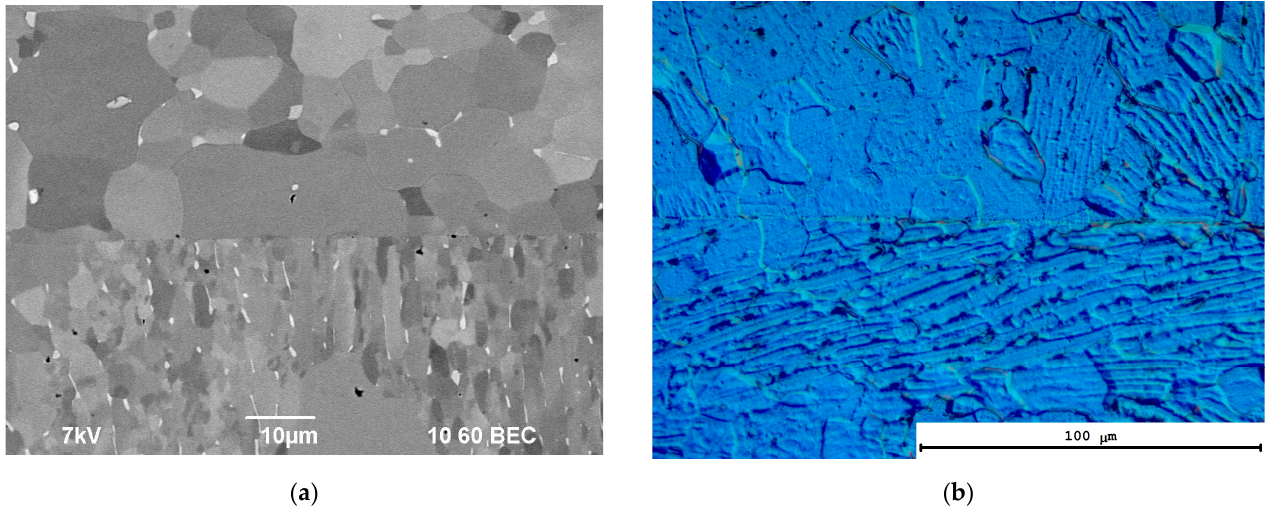
Figure 13. Nonuniformity of the metal microstructure in the weld joint area of the coarse-grained titanium alloy: ( a ) SEM; ( b ) Metallography.